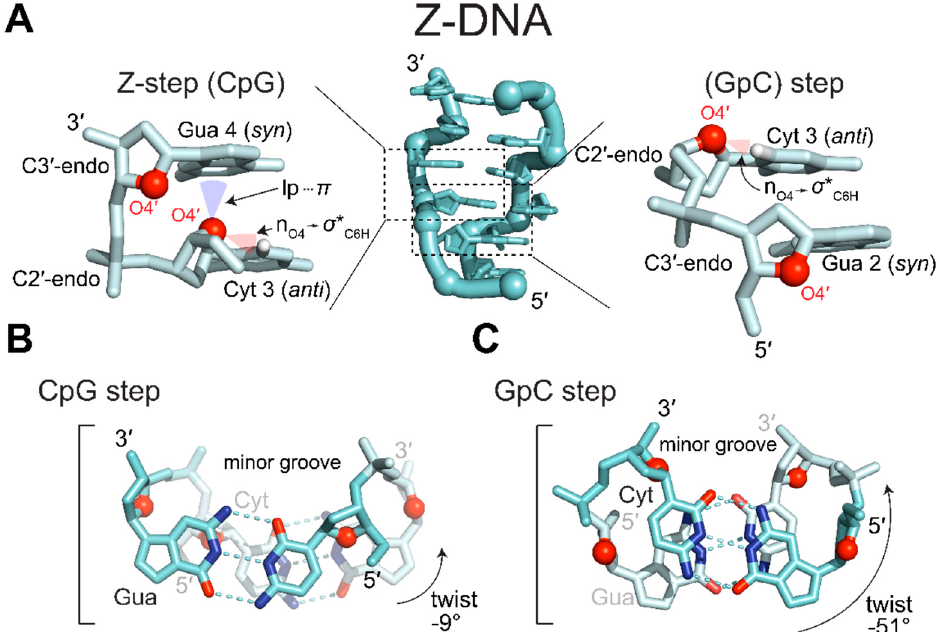
Figure 2. The building block of the Z-conformations are two distinct dinucleotide steps. ( A ) d(CpG) 3 sequence in the Z-conformation (PDB: 7JY2 [33]). Z-form nucleic acids are composed of two distinct, overlapping dinucleotides steps. In both steps, ribose O4 ′ (red spheres) alternate between “pointing up” and “pointing down”. Pyrimidines adopt anti conformations and C3 ′ -endo puckers, whereas purines adopt syn conformations and C2 ′ -endo puckers. On the left, the Z-step ( anti -p- syn ) exhibits a unique contact not typically seen in other steps or helical conformations. One lone pair of oxygen O4 ′ sits within the vdW depression of the guanidinium system, resulting in lp··· π contacts and close nucleobase plane distances. The other lone pair of oxygen O4 ′ facilitates an n O4 → σ * C6H hypercon- jugation. The other step ( syn -p- anti ) does not include the lp··· π contacts but does include the n O4 → σ * C6H hyperconjugation. ( B ) Top-down view of the CpG step. O4 ′ can be seen pointing into guanine’s six-membered ring close to C2 and the interstrand cytidine base stacking can also be seen. ( C ) Top- down view of the GpC step. There is no lp··· π contact and only intrastrand base-stacking occurs. Alternating anti / syn conformations and C2 ′ -endo/C3 ′ -endo puckers within alternat- ing pyrimidine/purine (APP) repeats results in a dinucleotide repeating unit [1], as op- posed to the mononucleotide unit seen in A-RNA and B-DNA. Successive, overlapping dinucleotides adopt two distinct conformations, CpG ( anti -p- syn; “Z-step” [34]) and GpC ( syn -p- anti ) (Figure 2A). For example, in the CpG step (Figure 2B), there is little rotation ( − 9°) between the nucleotides, whereas the GpC step (Figure 2C) has a much larger